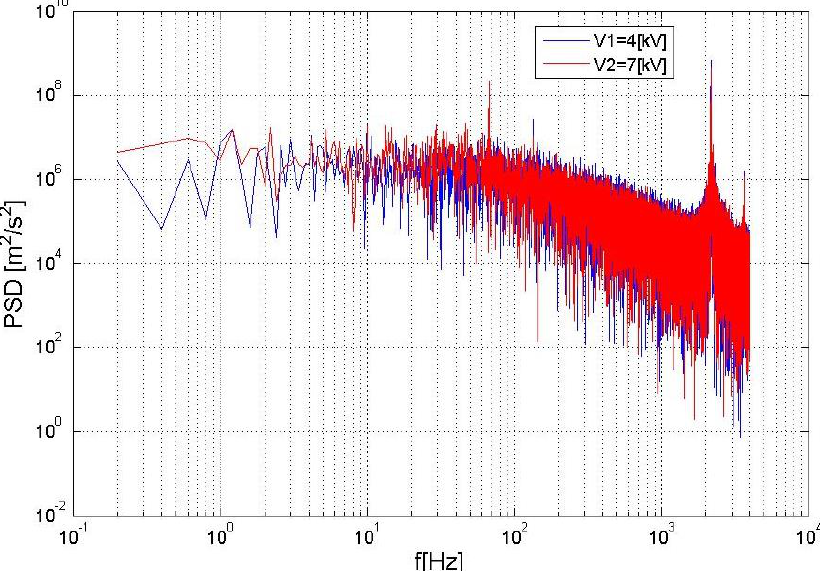
Figure 19. PSD analysis comparing applied voltages at Re = 100,000 and α = 16 ◦ , and actuation frequency f =